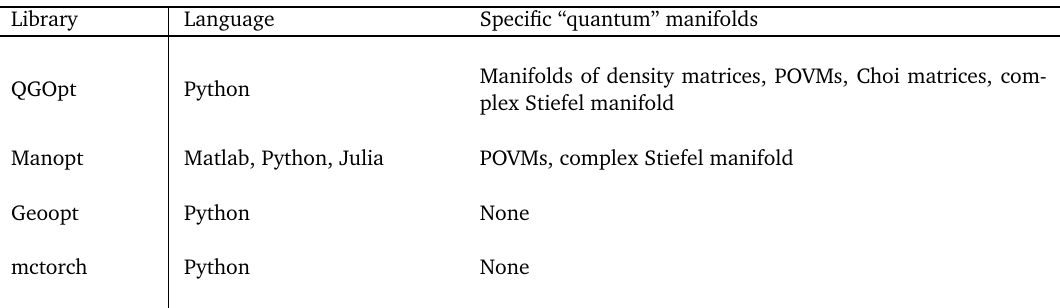
Table 4: Comparison of the QGOpt library with other libraries for Riemannian opti- mization in terms of the supported “quantum”